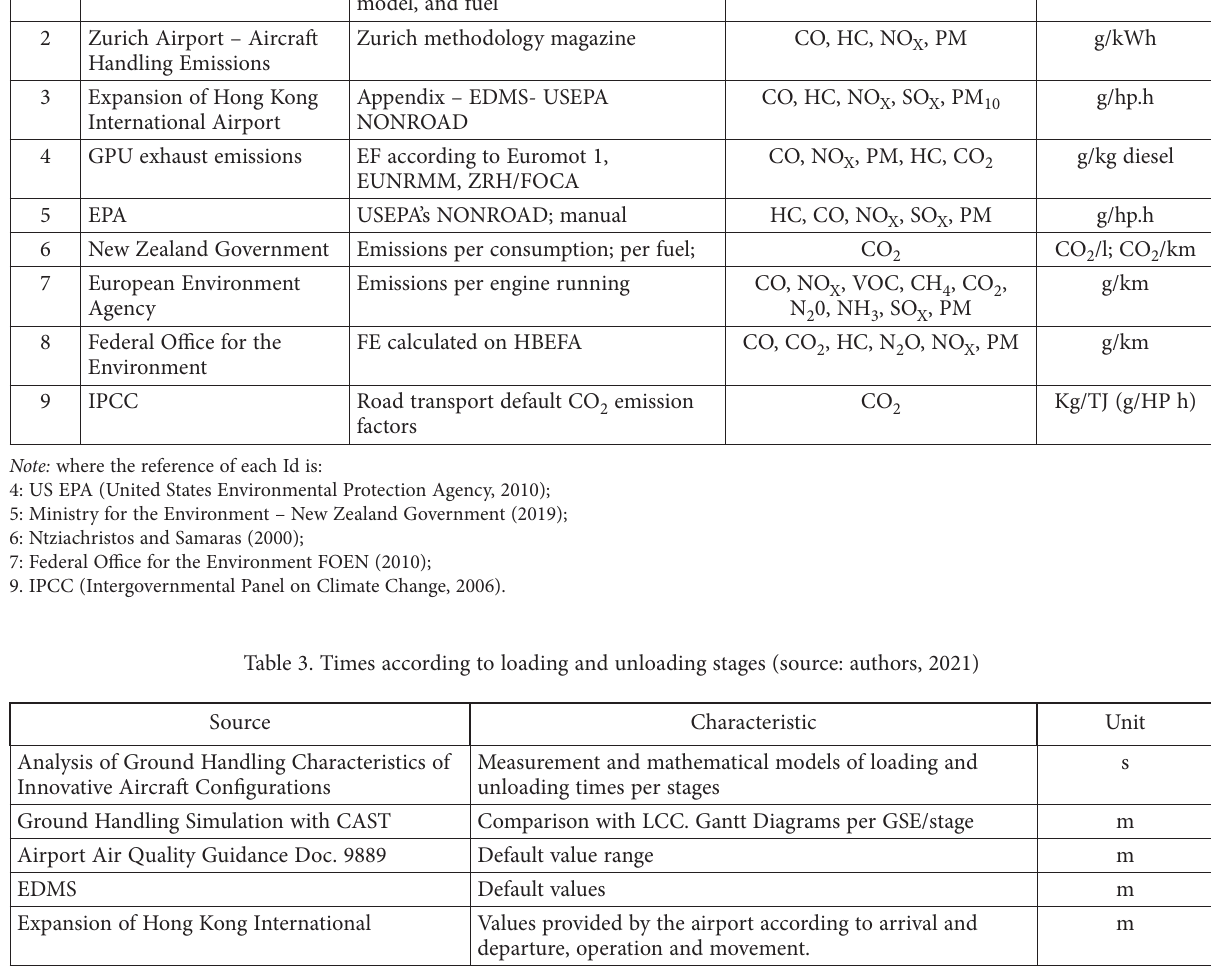
Values provided by the airport according to arrival and departure, operation and movement.